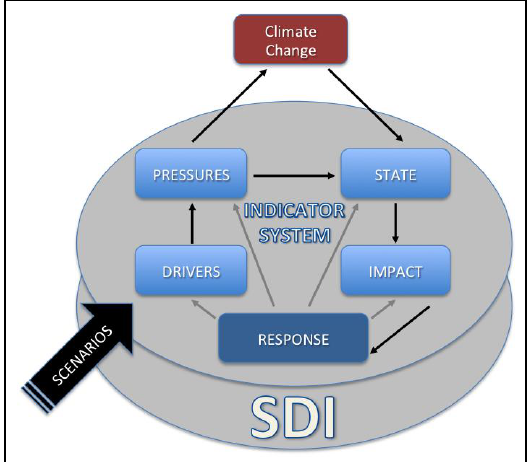
Figure 1. The ICZM decision-support